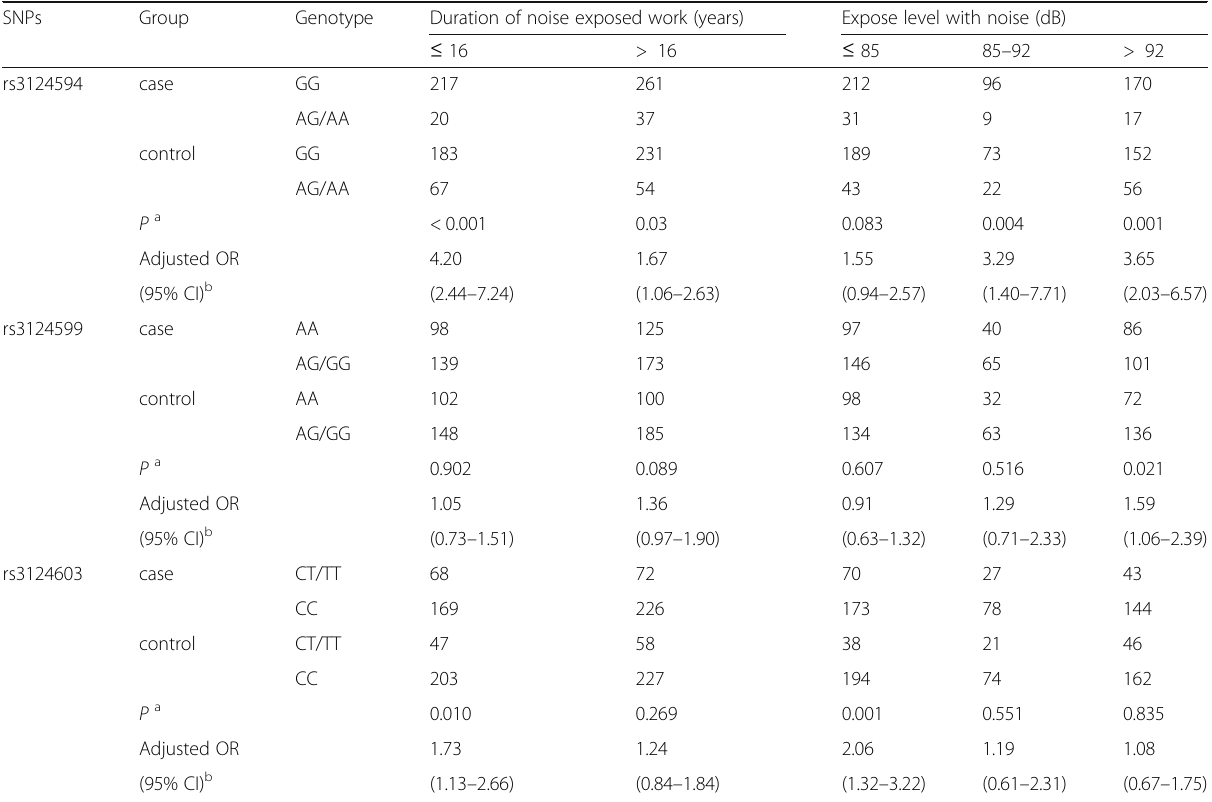
Table 4 Stratified analysis of SNPs in a recessive model SNPs Group